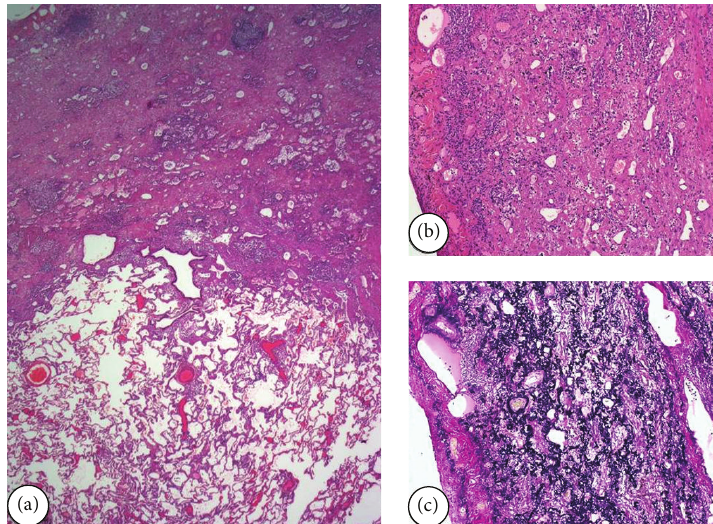
Figure 4: Case 1. (a) Microscopic examination of explanted lung of Case 1 (right upper lobe). The increase of elastic fibers and abrupt transition to normal parenchyma is evident. HE 200x. (b) The involved areas show collapse of alveolar spaces by interstitial material that corresponds to elastic fibers. Scant lymphocyte infiltrate. HE 400x. (c) Van Gieson stain demonstrates abnormal elastic fibers in the thickened